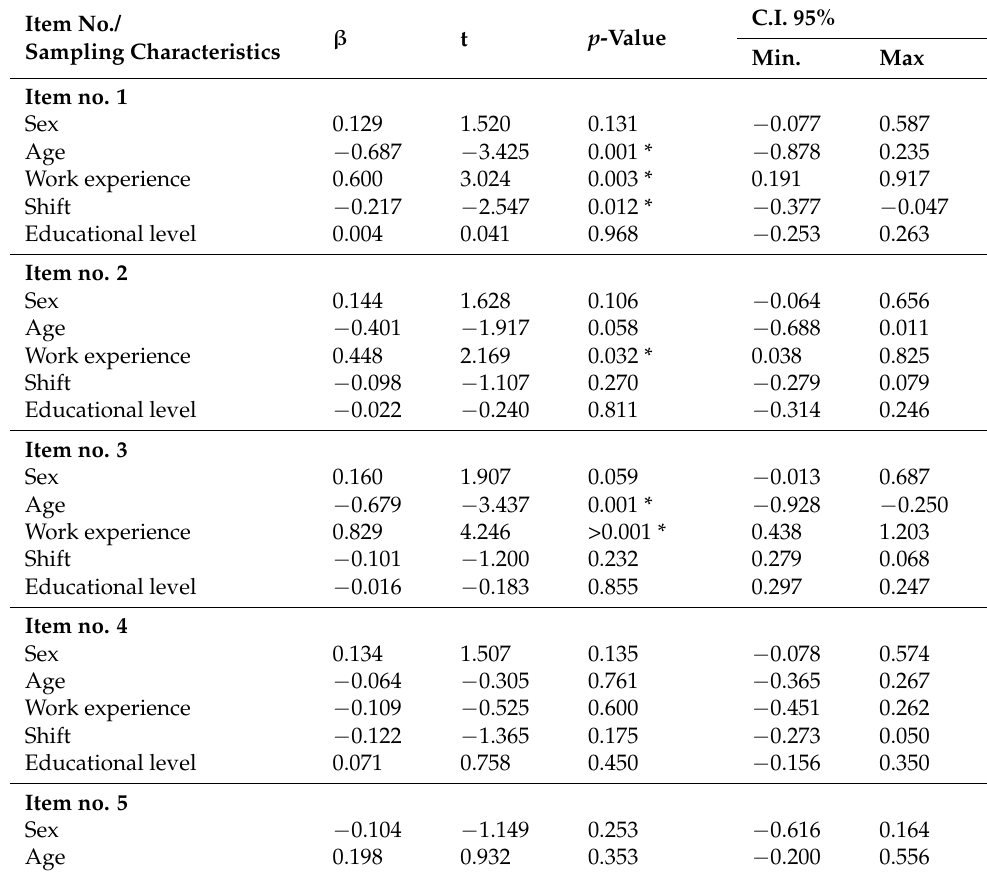
Table 3. Associations between Nurses’ perceptions on their work activities and environments during the COVID-19 pandemic and sampling